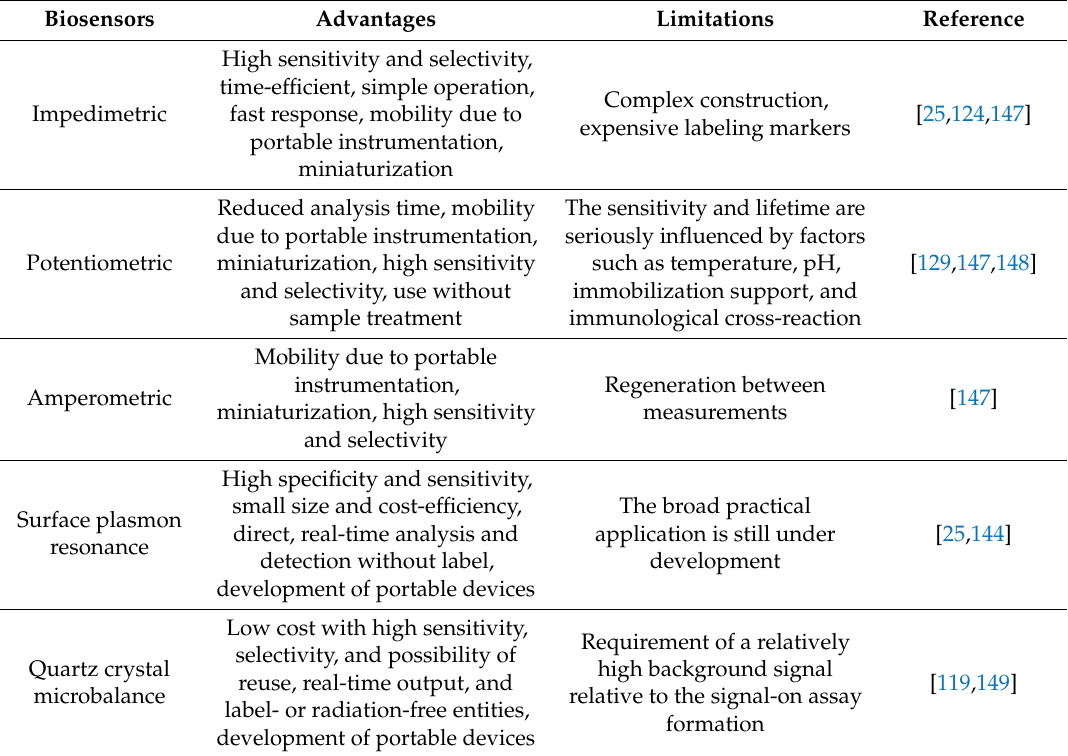
Table 6. Advantages and limitations of biosensors in mycotoxin